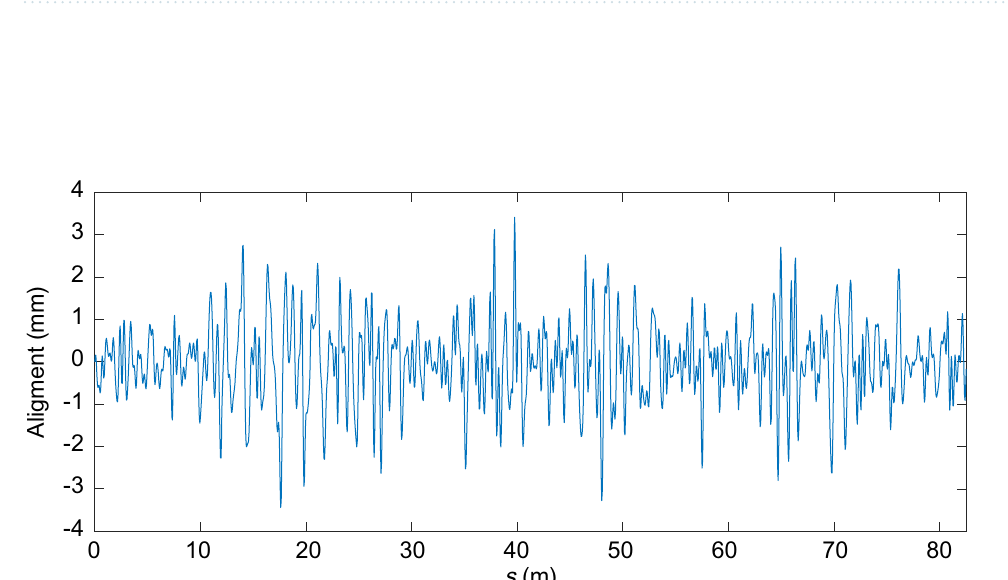
Figure 19. Filtered scaled track alignment